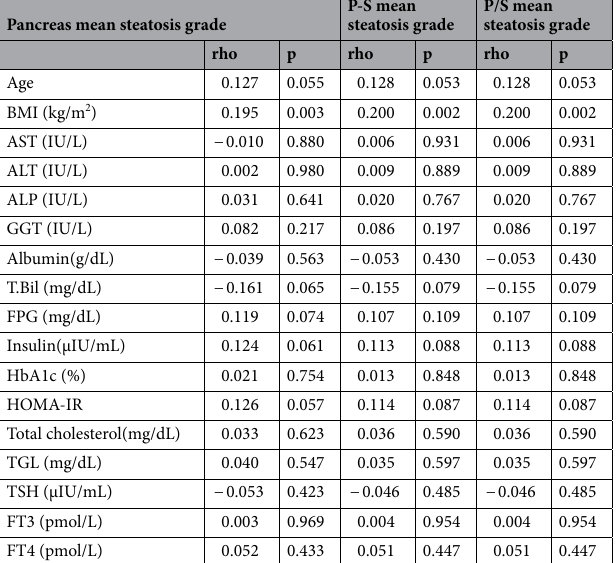
Table 6. Correlation analysis between demographic, laboratory data and pancreatic steatosis in study. Spearman correlation analysis.